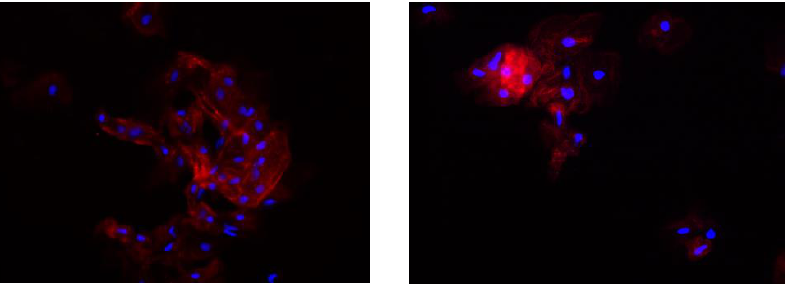
Figure 3. Examples of buccal mucosa smears of healthy controls and ACM patients labeled for plakoglobin at different dilutions. ACM; arrhythmogenic cardiomyopathy.